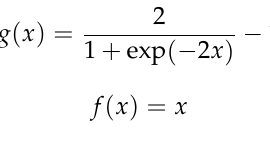
Figure 2. Structural diagram of backpropagation neural network.